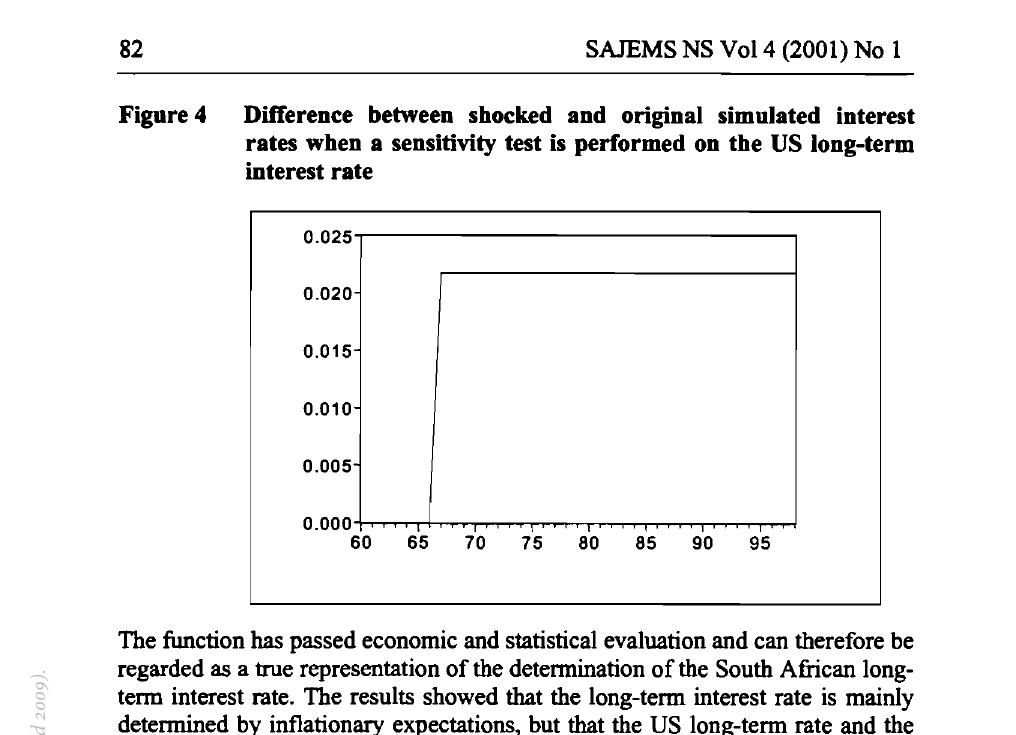
Figure 4 Difference between shocked and original simulated interest rates when a sensitivity test is performed on the US long-term interest rate